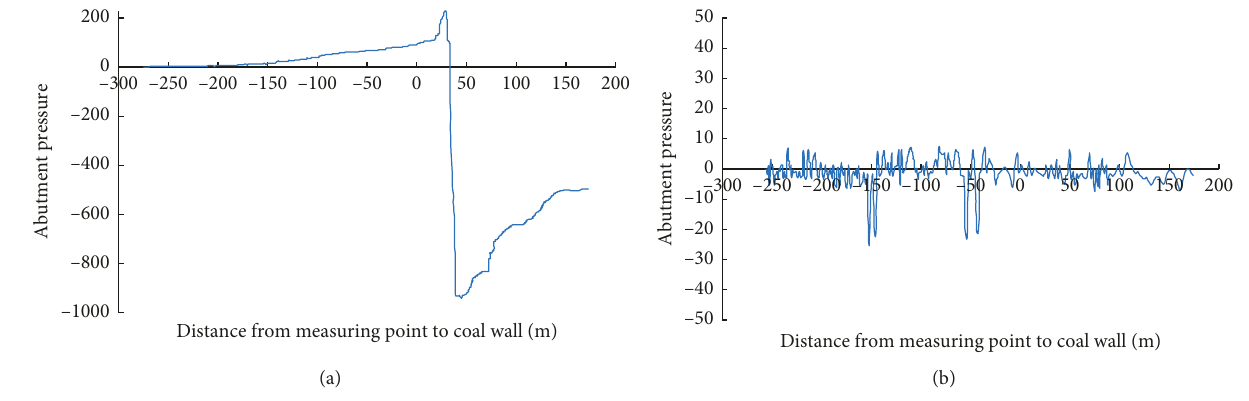
Figure 16: The changing curve of the abutment pressure in the roof as the advancement of working face at the floor strata 285 m away from the open cut (in the uphill mining section). (a) Roof (located at pressure cell 18). (b) Floor (located at pressure cell 8).